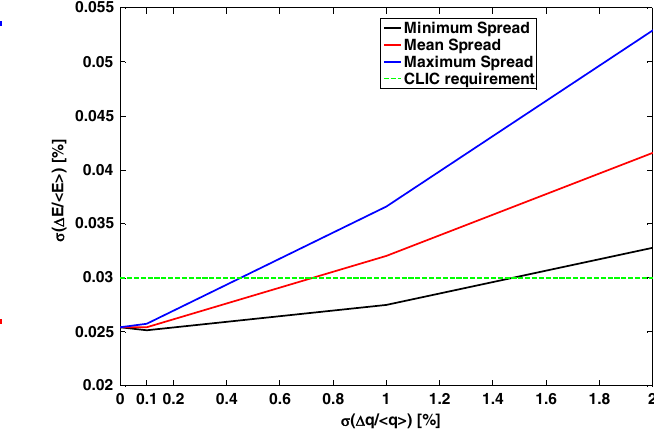
FIG. 21. The rms energy-spread minimization for different transient times when optimizing both the switching delays and injection time (red) and when adjusting only the injection time only (blue).